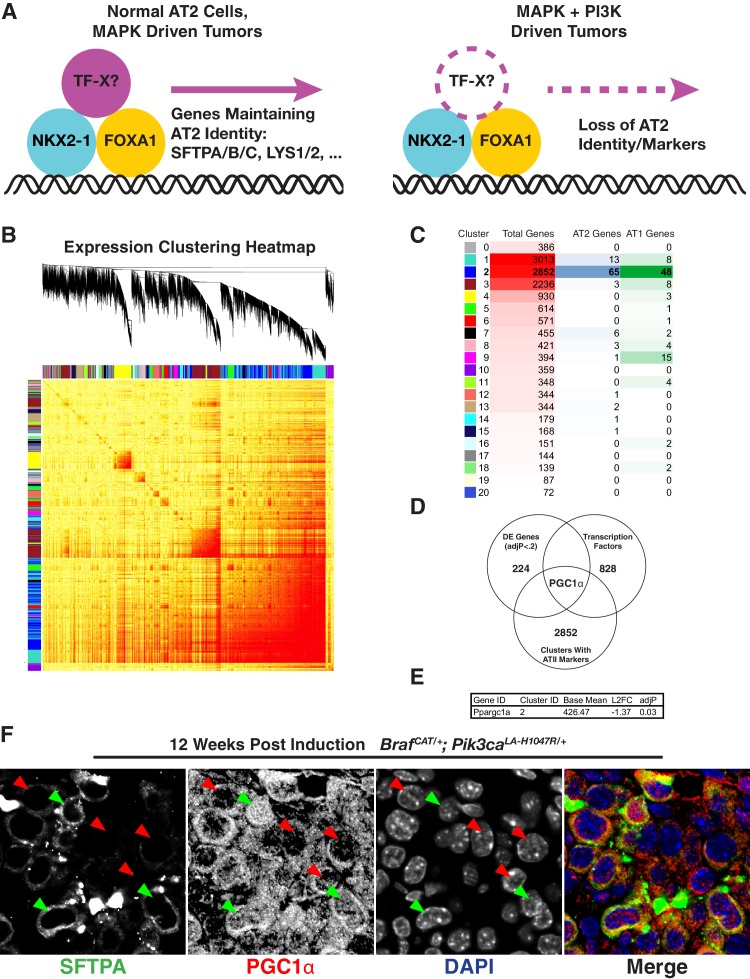
Loss of PGC1α Expression Correlates With Change in Expression of Lung Markers.(A) Hypothetical model showing an additional factor cooperating with lung lineage transcription factors that is downregulated upon dual arm mutational activation of growth factor signaling. (B) Weighted gene correlation network analysis (WGCNA) heat map identifies 21 correlated gene expression modules. Gene tree shows relationship of individual genes, where multi-color bars adjacent to heat map identify individual clusters. (C) Table summarizing result of WGCNA analysis and AT1/AT2 memberships. Cluster number is listed adjacent to color corresponding to cluster in (B). For each cluster, shown is the total number of genes along with the number of AT1 and AT2 marker genes from AT1-100 and AT2-100. Cluster two contains the majority of both AT1 and AT2 marker genes. (D) A three factor approach to identify novel regulators of pneumocyte identity. Within the intersection of differentially expressed genes, genes co-regulated with the majority of AT1 and AT2 specific genes, and known transcription factors, lies a single gene, PGC1α. (E) PGC1α is significantly downregulated in BRAFV600E/PI3Kα H1047R driven tumors compared to BRAFV600E driven tumors; adjP is Benjamini-Hochberg corrected P value from DESeq2. (F) Decreased nuclear PGC1α immunoreactivity (red arrows) correlates with loss of AT2 identity on a cell by cell basis. AT2 identity is maintained in those cells which maintain nuclear PGC1α immunoreactivity (green arrows).10.7554/eLife.43668.033Figure 6—source code 1.R script to perform weighted correlation network (WGCNA) on Figure 6—source data 1.10.7554/eLife.43668.034Figure 6—source data 1.DEseq2 normalized RNA-seq count output of all BRAFV600E/PI3KαH1047R and BRAFV600E driven tumors.